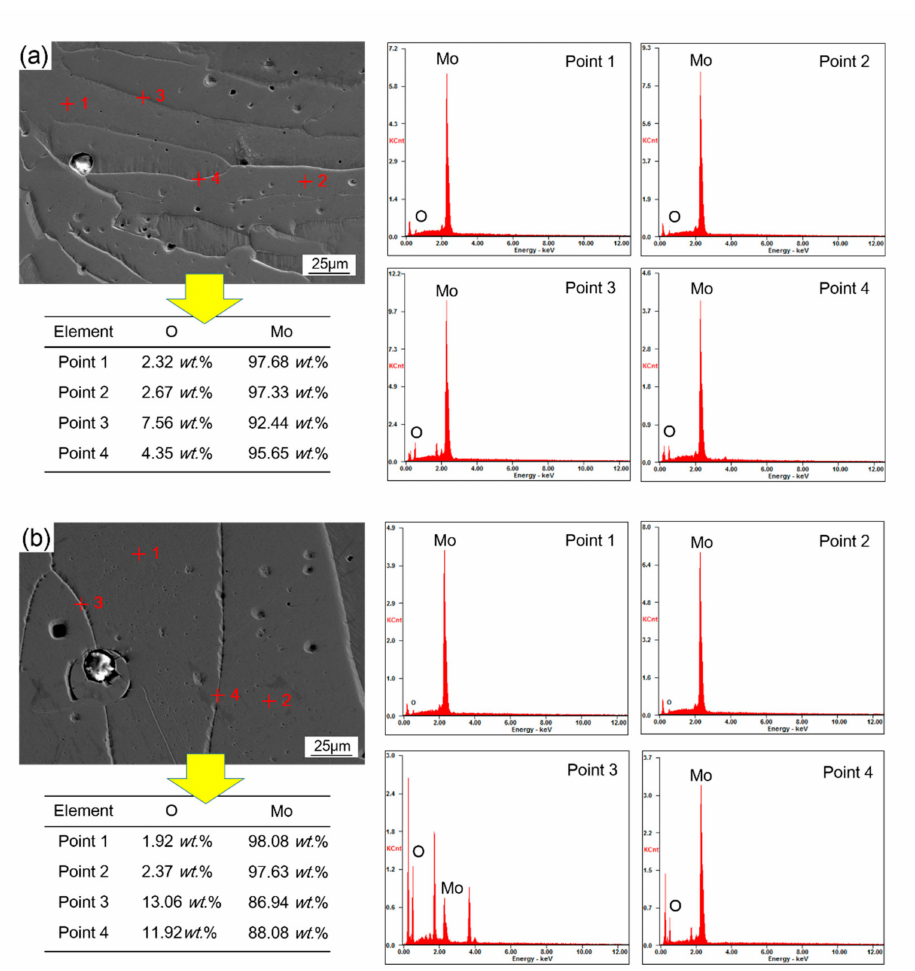
Figure 13. SEM images and EDS results in the fusion zone of NS Mo alloy welded joints. Heat input: ( a ) 250 J / cm; ( b ) 3600 J / cm.